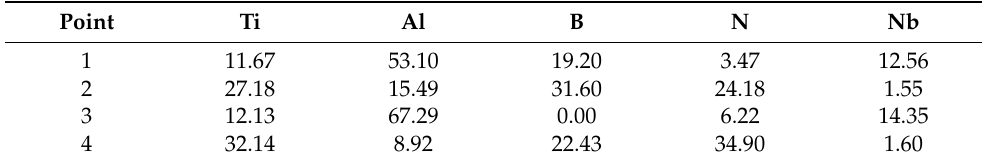
Figure 5. Microzonal composition analysis and EPMA results of cBN composites: ( a ) microzonal composition analysis; ( b ) layer structure of cBN composite; ( c ) EPMA map of Ti element; ( d ) EPMA map of Al element; ( e ) EPMA map of Nb element. Table 1. Microzonal composition analysis of cBN composites in Figure